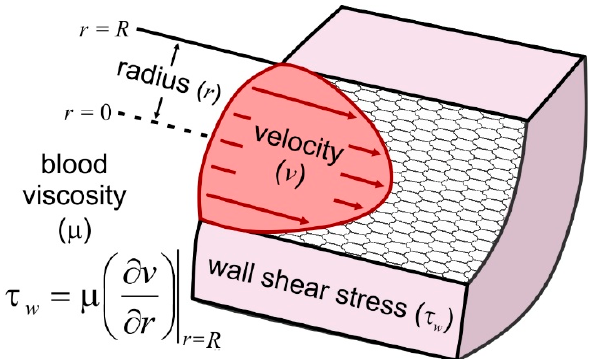
Figure 1. The figure provides an illustration of the velocity profile experienced by endothelial cells lining an artery as a result of blood flow, and a general expression for wall shear stress ( τ w ; WSS). In its simplest form, WSS can be defined as the frictional force imposed on the blood vessel wall. For this simple case, WSS is the product of viscosity ( µ ) and the shear rate, which is also known as the rate of deformation or near-wall velocity gradient ( ∂ v/ ∂ r ). Adapted from Samyn and LaDisa [52]. In practice, a value for the density of blood is typically selected from the